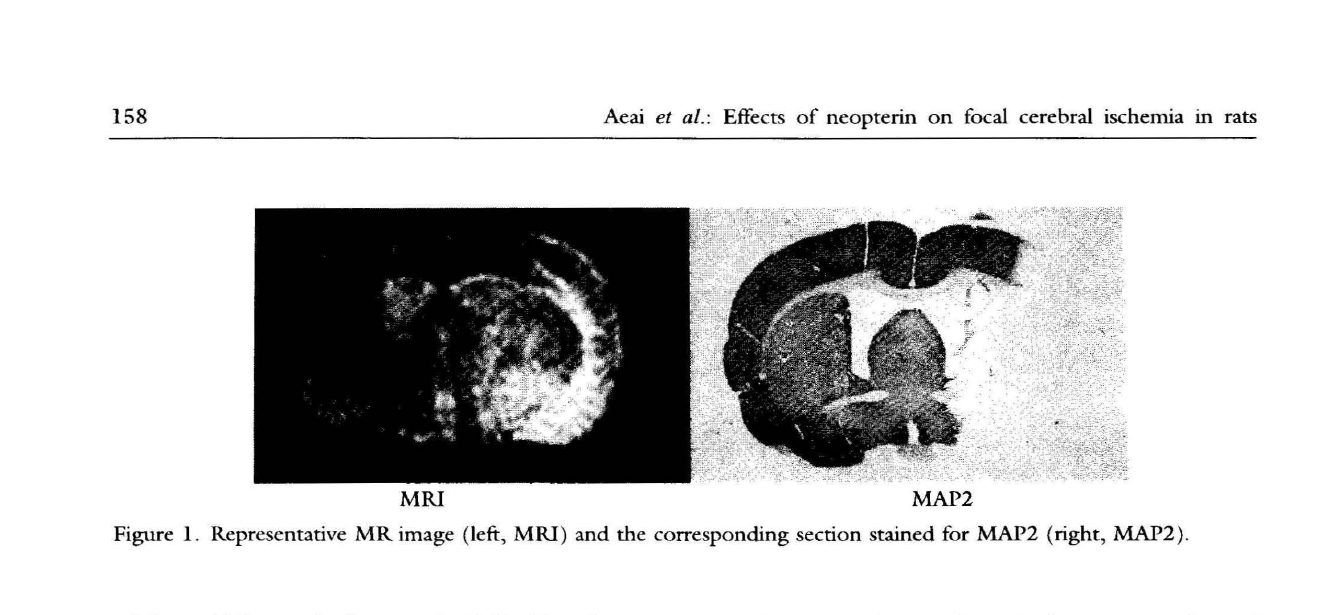
MRI MAP2 Figure L Representative MR image (left, MRI) and the corresponding section stained for MAP2 (right,